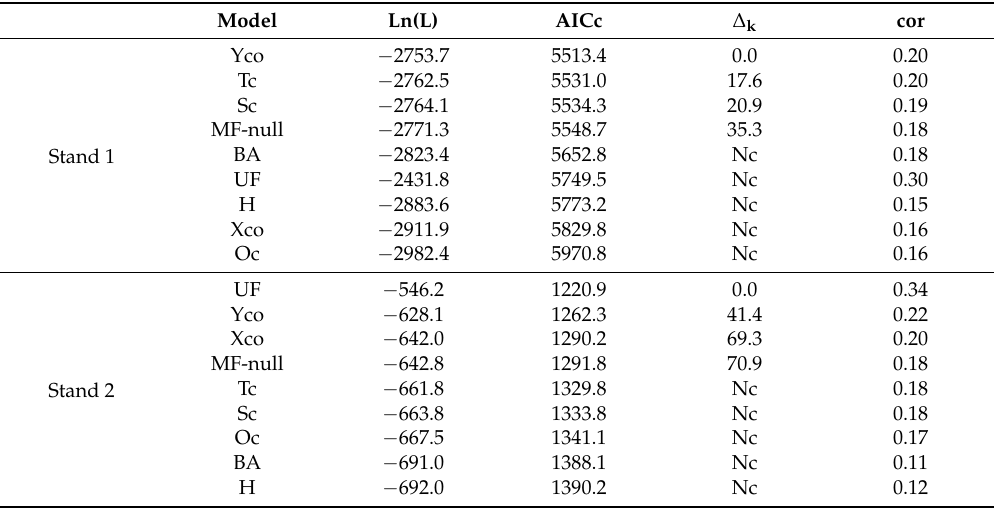
Table 3. Comparison statistics for different dispersal-and-fecundity models for the two stands (models are ordered, within each stand, according to smaller